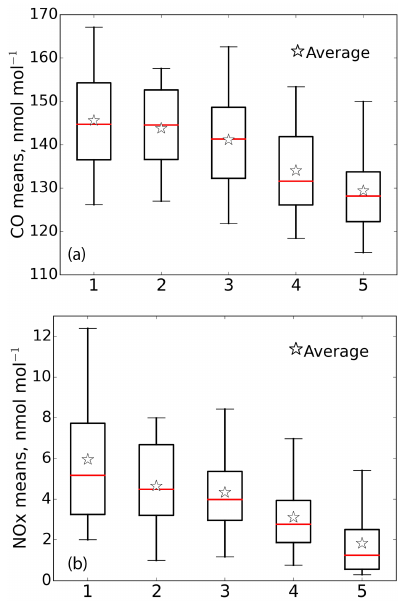
Figure 7. Percentiles (5–25–50–75–95) of modeled CO (a) and NO x (b) means in clusters; first CA.